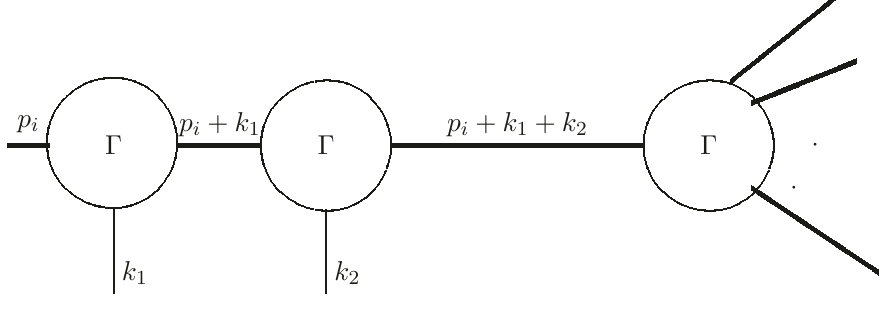
Figure 4 . Two external soft gravitons attached to the same external line carrying finite momenta.